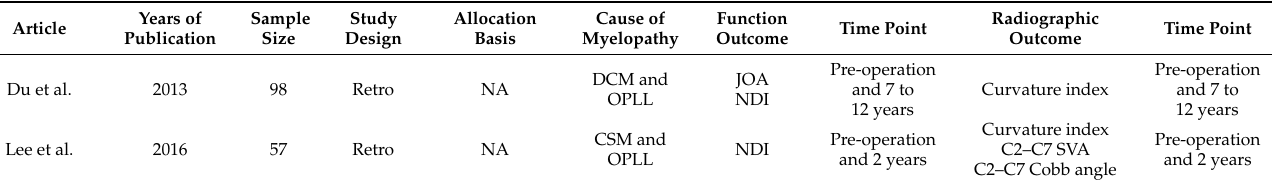
Table 4. Studies describing laminoplasty versus laminectomy with and without